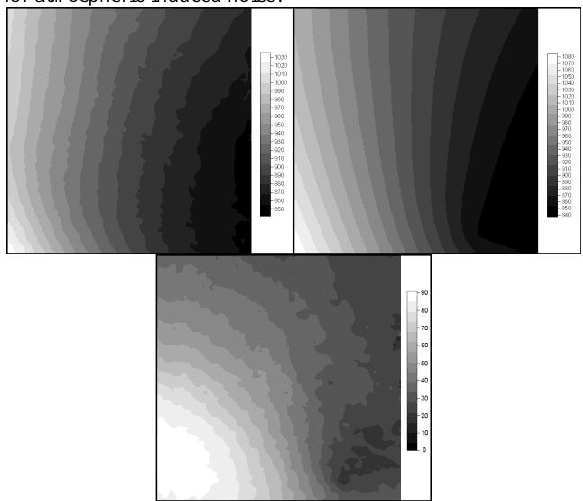
Figure 1. a. DEM before the time of SAR acquisition. b.